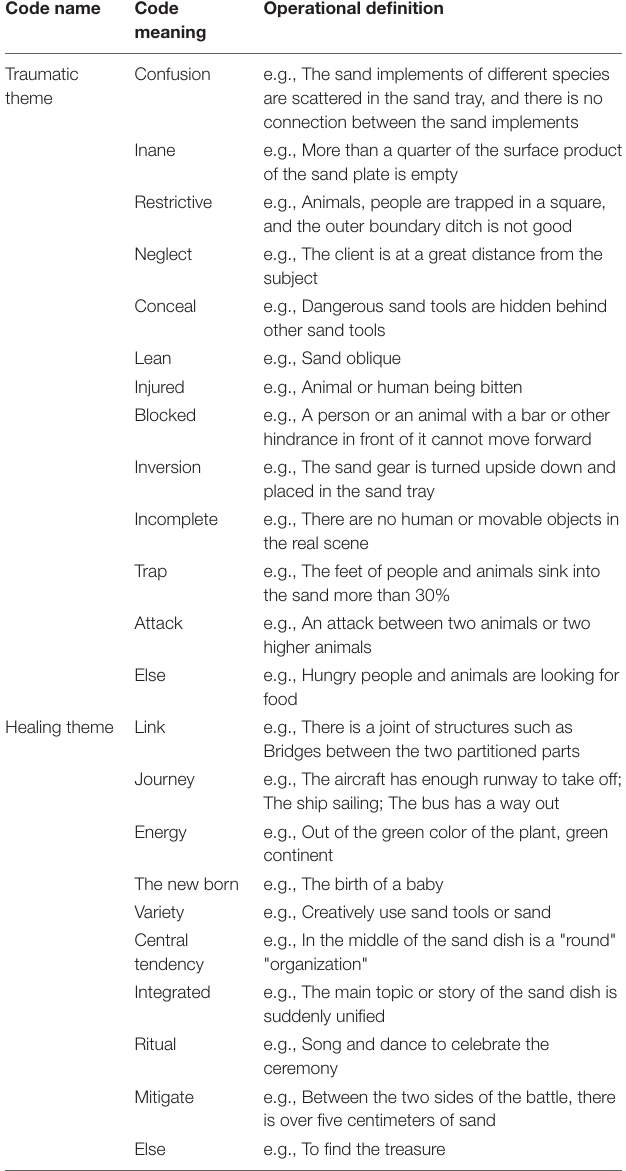
TABLE 2 | Theme coding of